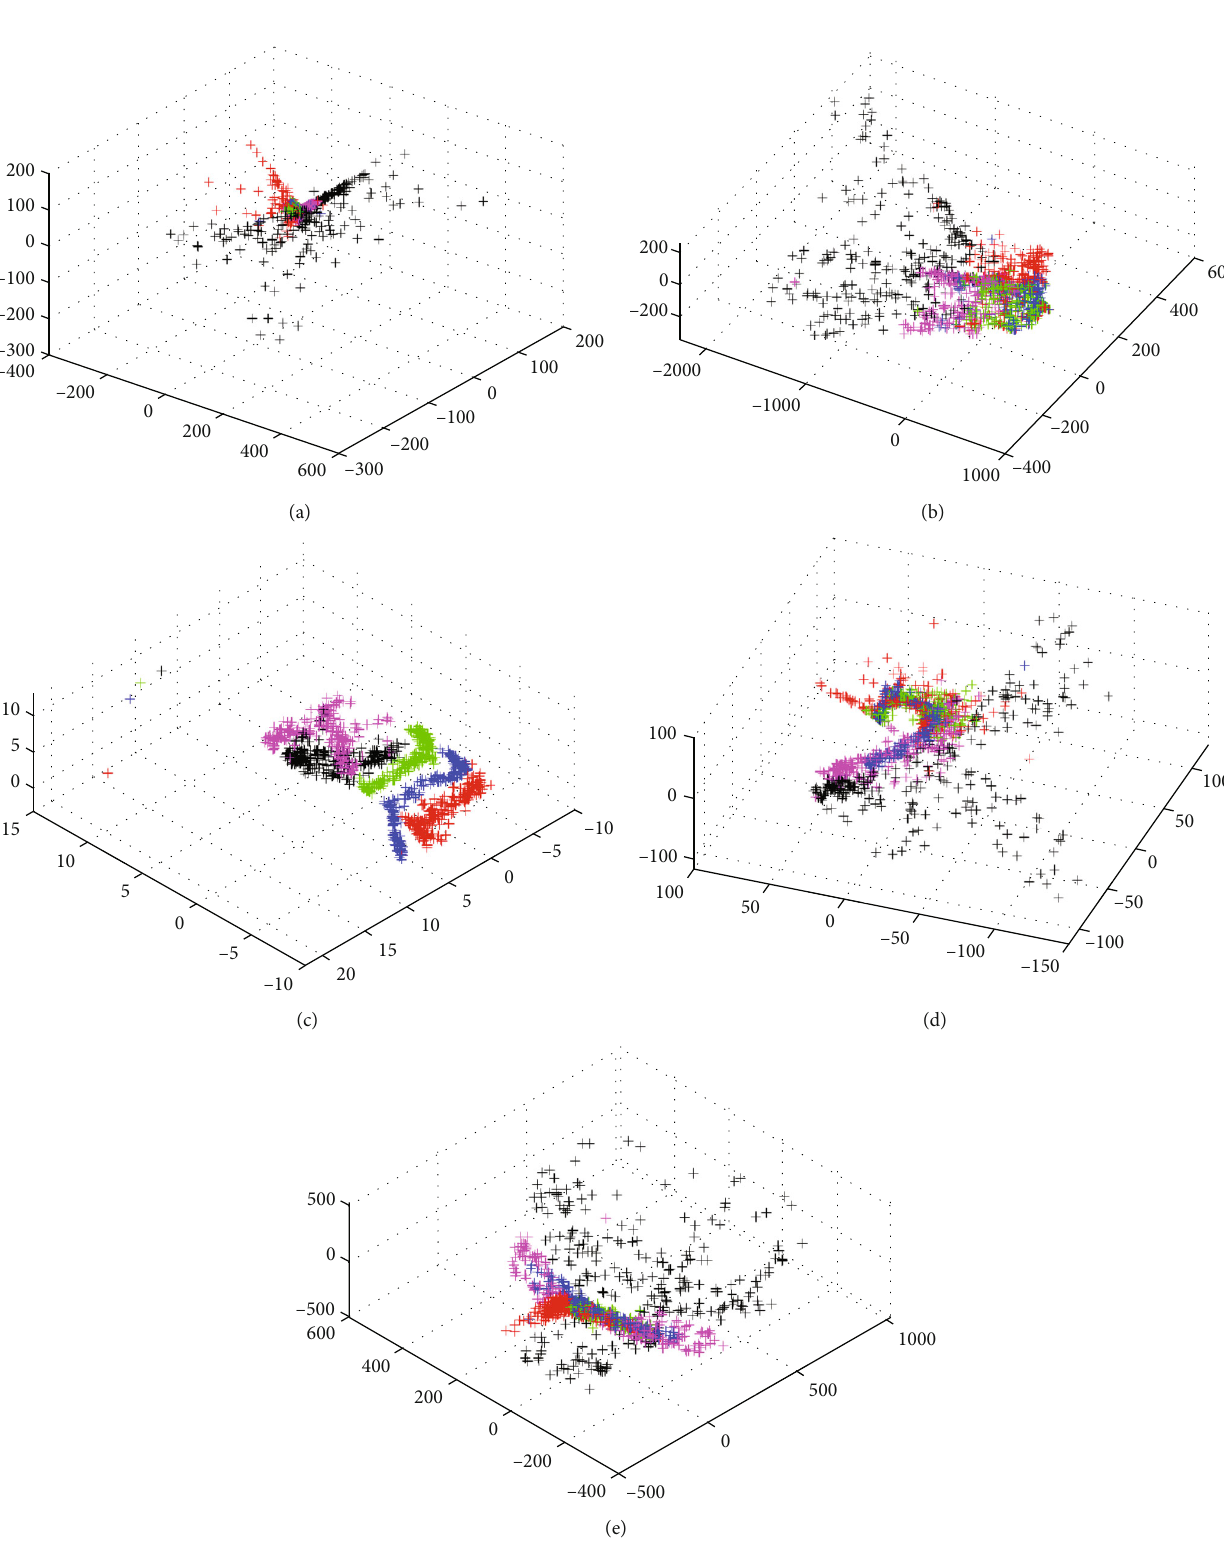
Figure 20: Distribution of the features in a 3-dimensional space: (a) the 3-D distribution of the T3 trace feature; (b) the 3-D distribution of the 1 × 1 LBP feature; (c) the 3-D distribution of the fusion feature T3_ 1 × 1 LBP (3-dimensional fusion features which have the best classi fi cation performance); (d) the 3-D distribution of T1 trace features (trace features which have the best classi fi cation performance); (e) the distribution of the 11 × 11 LBP feature (LBP features which have the best classi fi cation